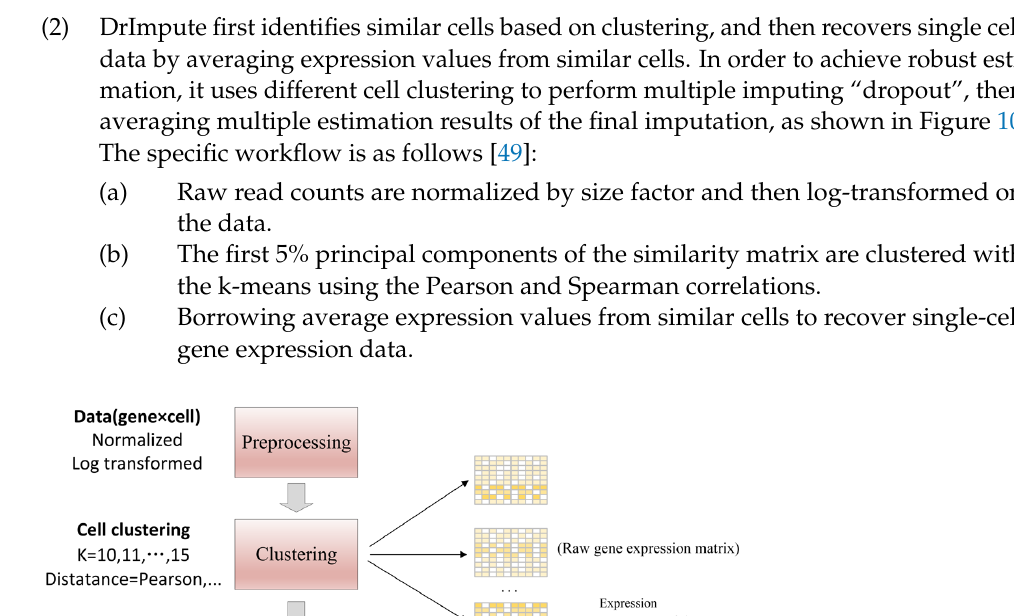
Figure 9. The framework of MAGIC method [36].